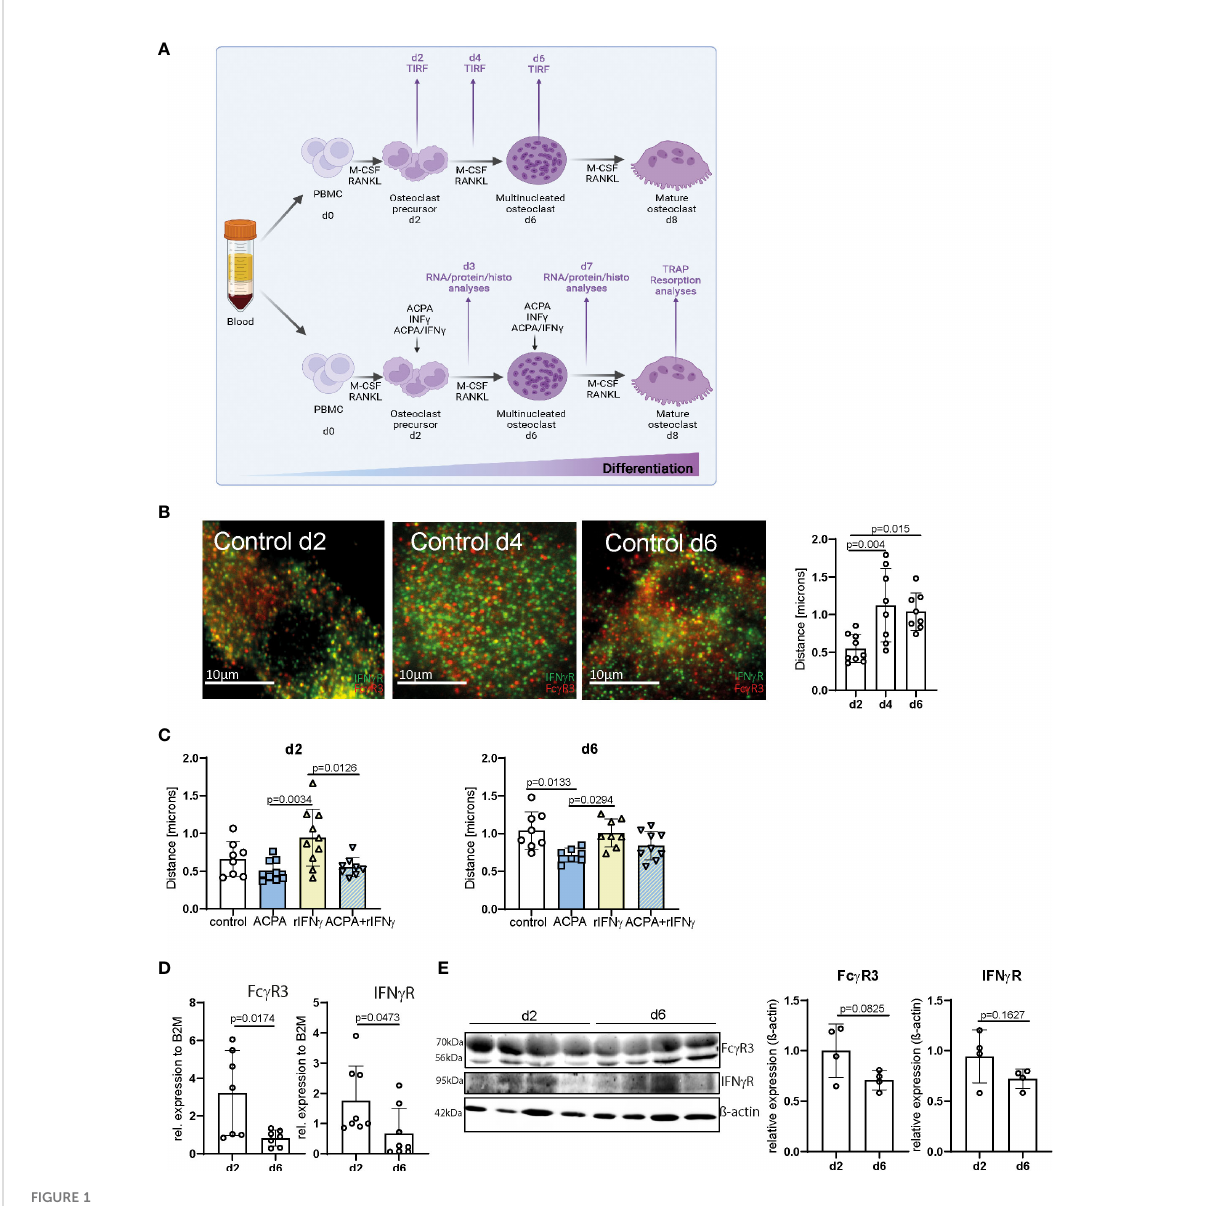
FIGURE 1 Fc g R3andIFN g Rarelocatedincloseproximitytoeach otherontheosteoclastplasmamembrane. (A) Schemedepictingtheprocess of in-vitro human peripheral bloodmononuclearcell (PBMC)differentiationintomature polynucleatedosteoclastsby humanM-CSFandhumanRANKLstimulationfor7/ 8 days. (B) Representative totalinternal re fl ection fl uorescence (TIRF)microscopypicturesof fi xed in-vitro differentiatedosteoclastsfromhumanPBMCsat thestageof osteoclastprecursors day2 (d2), multinucleatedosteoclast(d4), andpremature osteoclasts(d6)(left). DistanceofFc g R3 (red)andIFN g R (green) measuredat theindicatedtimepointsby anImageJplugin(local maxima)(right)resolutionin x / y / z of TIRFimagesis200nm. (C) Analysesofreceptor distanceafterstimulationof in-vitro differentiatedPBMCsond2, d4, andd6 for24h withthe indicatedstimuli. (D) Real-timegene expressionanalyses in humanosteoclastsdifferentiated invitro for2days (d2)or6 days (d6)with 30ng/mlofM-CSFand5 ng/mlof RANKL. Eachpointindicates theresults fora single donor. (E) Westernblot(left)andquantitativeanalyses(right)of Fc g R3andIFN g Rlevel inhumanosteoclastsdifferentiated in vitro for2 days(d2)or 6 days(d6)with30ng/ml of M-CSFand5ng/ml of RANKL. QuantitativeanalysesofWestern blot bandswereassessedby ImageJ. Dataarethemean − /+ s.d. One-way ANOVA (B,C) andStudent ’ s t -test (D,E) wereusedforthe analysis,and thecorresponding p -valuesareindicatedin the fi